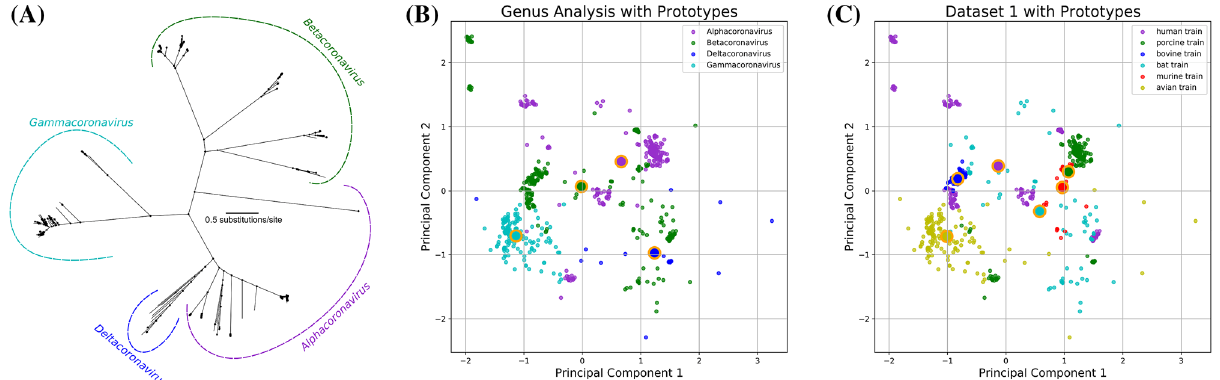
Figure 1. Characterization of the training dataset (Dataset 1). ( A ) Phylogenetic characterization estimated based on maximum likelihood, and showing all the Coronaviruses genus. The tree was generated with IQ-TREE 1.5.5 21 available at http:// www. iqtree. org and visualized with FigTree 1.4.4 22 available at http:// tree. bio. ed. ac. uk/ softw are/ figtr ee/; ( B ) Two Dimensional PCA reduction with prototypes according to the different Coronaviruses genus; and ( C ) Two Dimensional PCA reduction with prototypes according to the different primary host. The different colours in ( B ) and ( C ) represents each group of genus or host class using the training data set (Dataset 1). For some hosts or even between the genus, we can observe some clouds of points concentrated, while in other conditions, as in bats, the samples are scattered in different positions of the